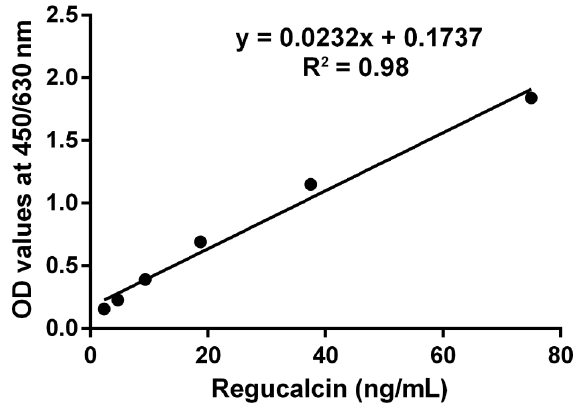
Figure 1 . Standard curve for regucalcin constructed using absorbance (optical density, OD) values and serum regucalcin concentrations. Table 1. Clinical characteristics of the healthy controls and the chronic hepatitis B (CHB) and acute-on-chronic liver failure (ACLF)